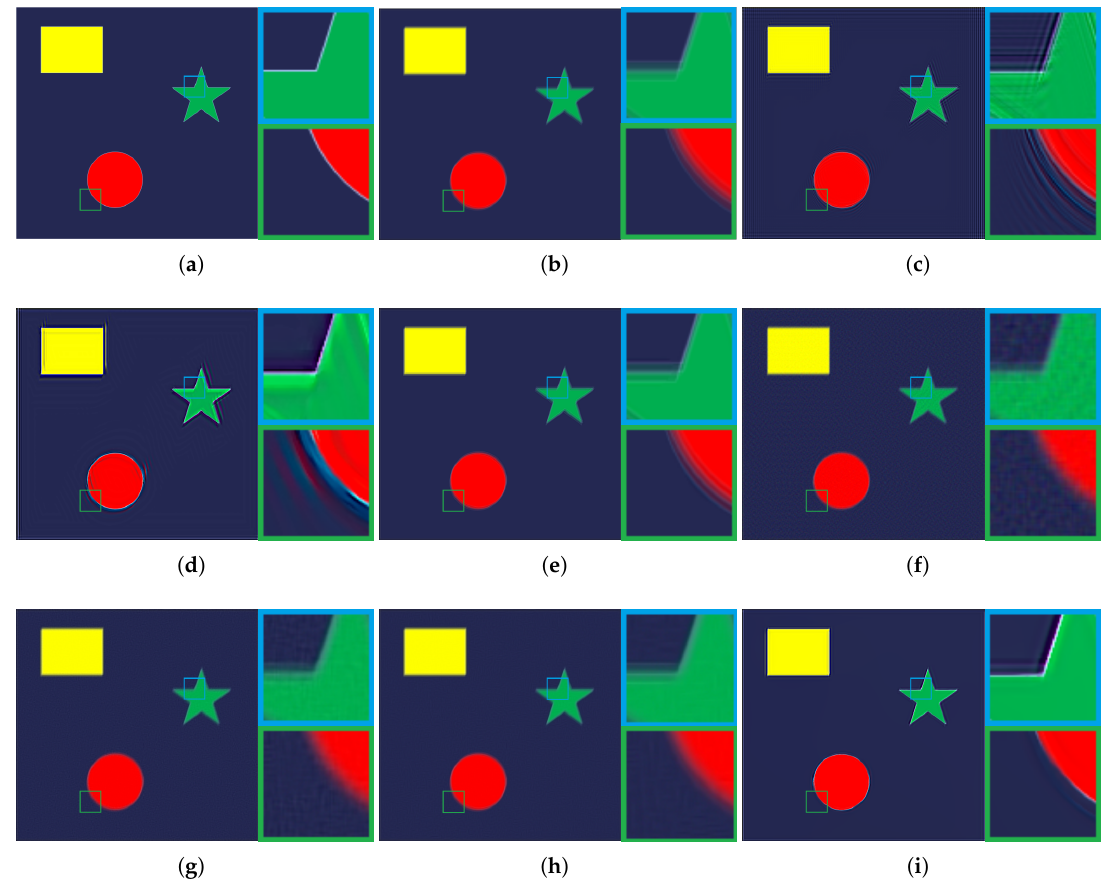
Figure 6. Comparison of different deblurring algorithms using a synthesis blurry image. ( a ) the original sharp image; ( b ) the blurry image obtained by a convolution between ( a ) and a blur kernel; ( c ) the deblurring result of Wiener filter; ( d ) the deblurring result of Xu’s method [33]; ( e ) the deblurring result of Shen’s method [34]; ( f ) the deblurring result of Yang’s method [35]; ( g ) the deblurring result of Dong’s method [26]; ( h ) the deblurring result of CSR method [36]; ( i ) the deblurring result of proposed